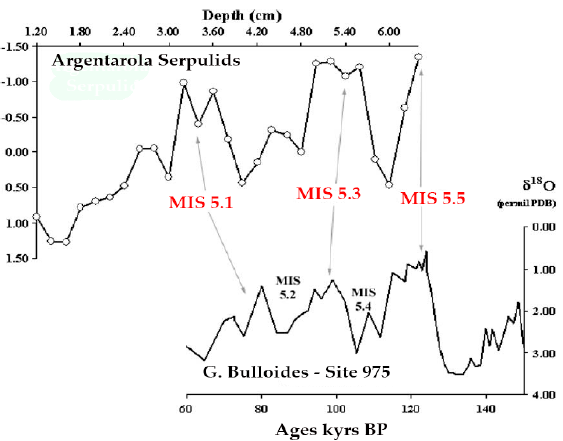
Figure 9. δ 18 O series of the marine layer of ASI ( − 18.5, MIS 5.5), compared with ODP 975 (Central Mediterranean sea) (redrawn from [21]).